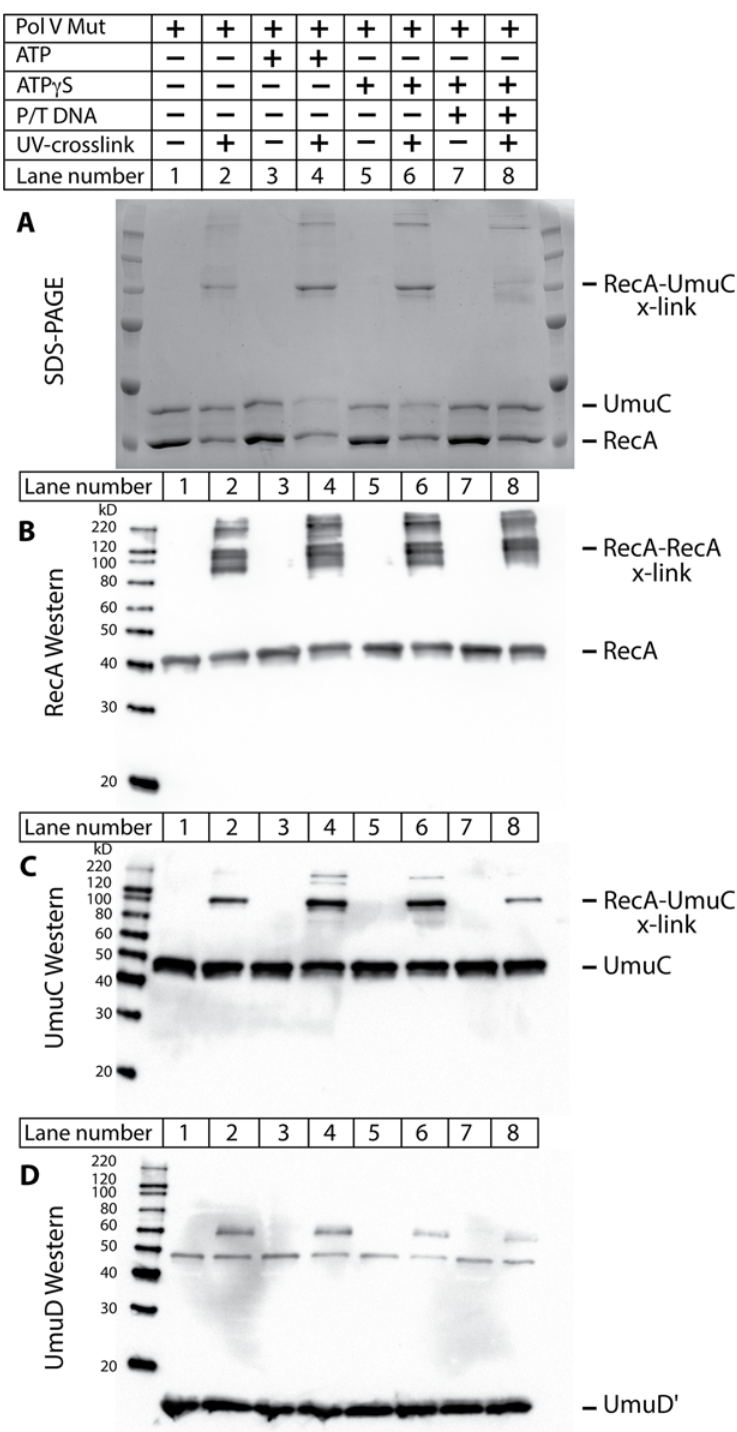
Fig 10. The RecA 3'-surface interacts with UmuC in pol V Mut. The photo-reactive unnatural amino acid Bpa was incorporated into RecA at position N113 (RecA N113Bpa) and used to probe RecA/pol V Mut interactions. The protocol for the generation of pol V Mut was followed as described in Methods, with ATP, ATP γ S, and template-primer added where indicated. Samples were exposed to UV light to covalently crosslink the RecA N113Bpa to nearby interacting partners (A) Coomassie stained SDS-PAGE of